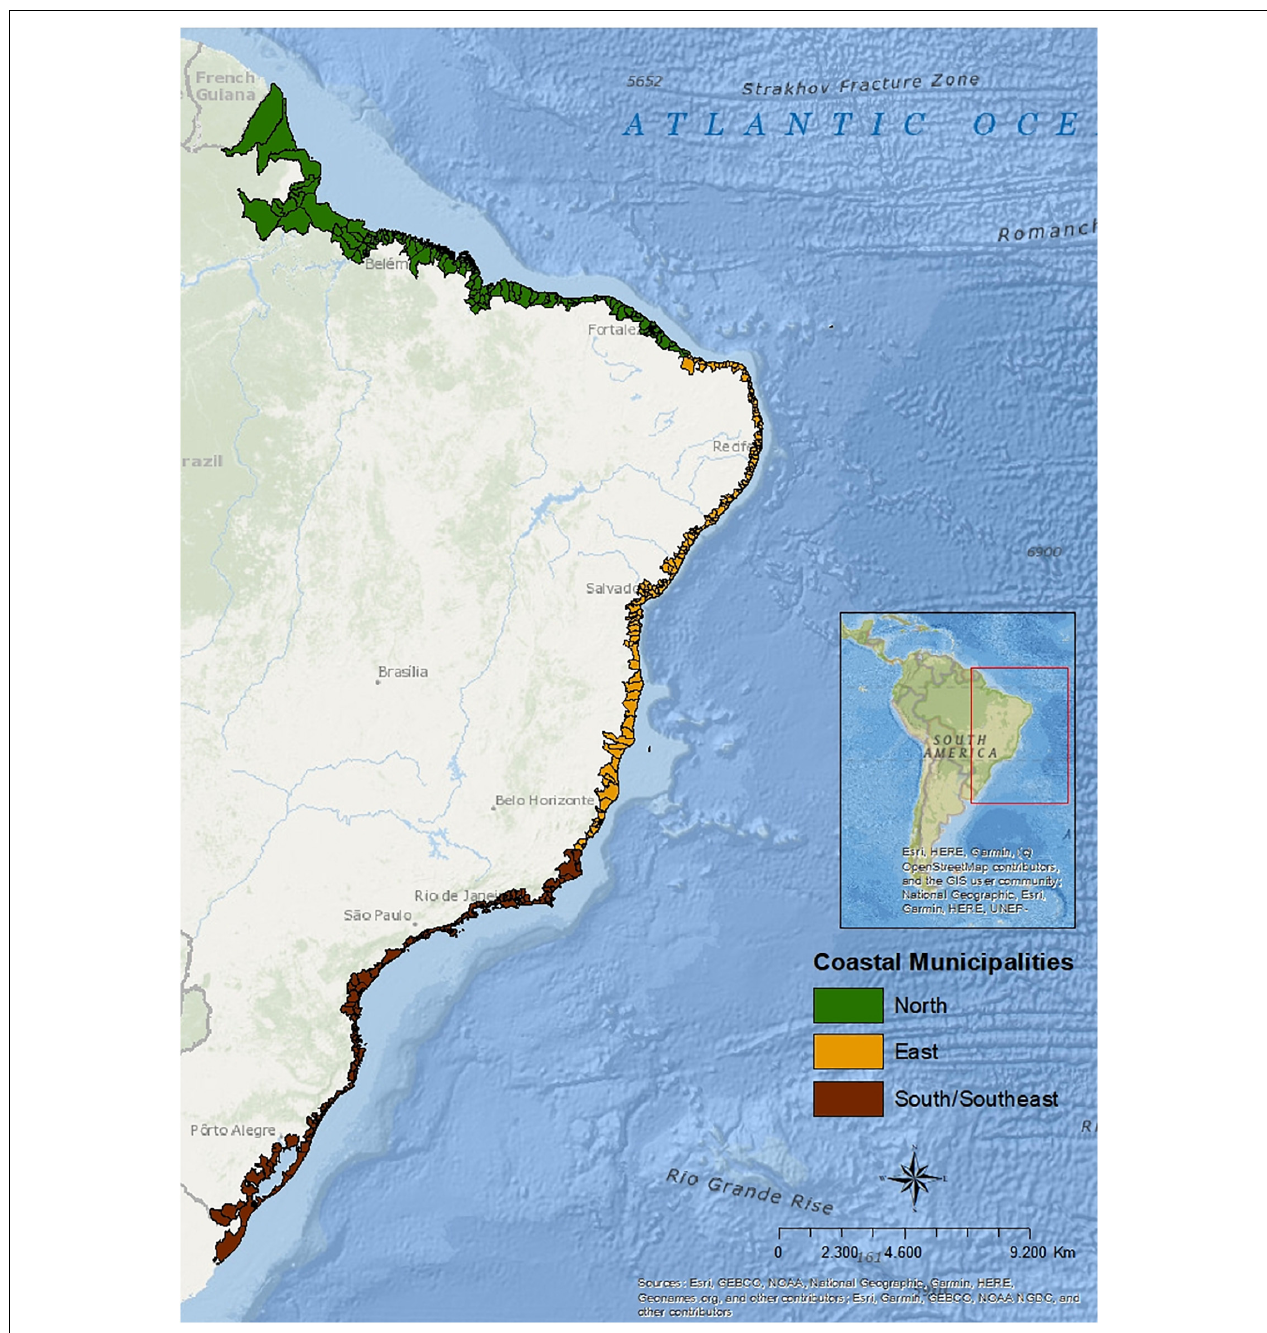
FIGURE 1 | Map of Brazil with the three coastal regions defined by this study. Elaborated by the